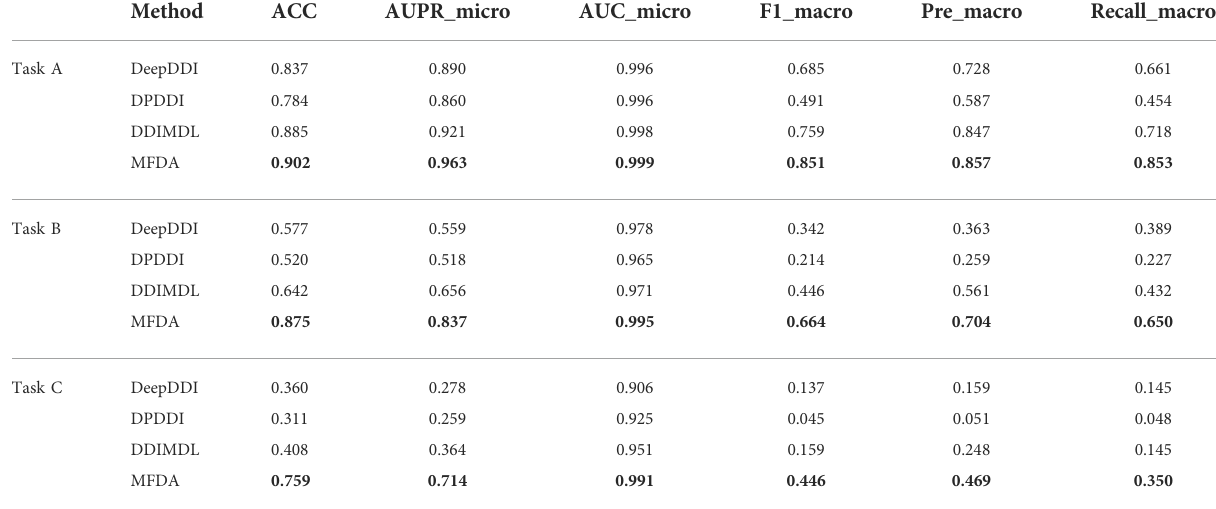
The best results are shown in